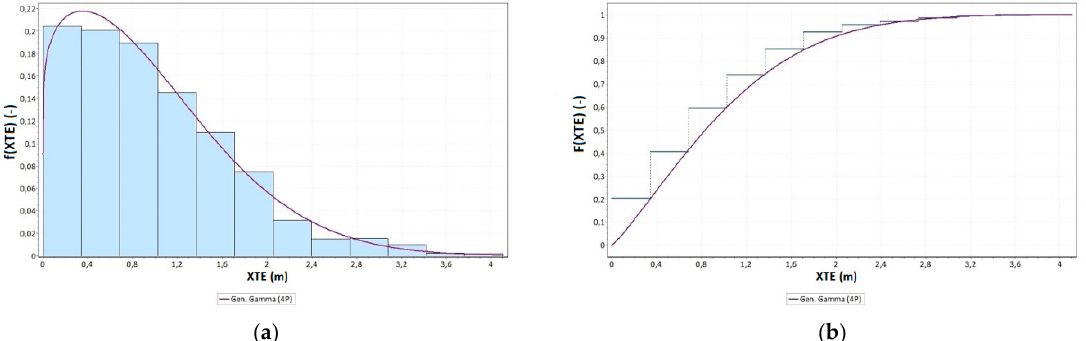
Figure 10. Probability density function ( a ) and cumulative distribution function ( b ) of the generalised gamma distribution of the XTE variable.